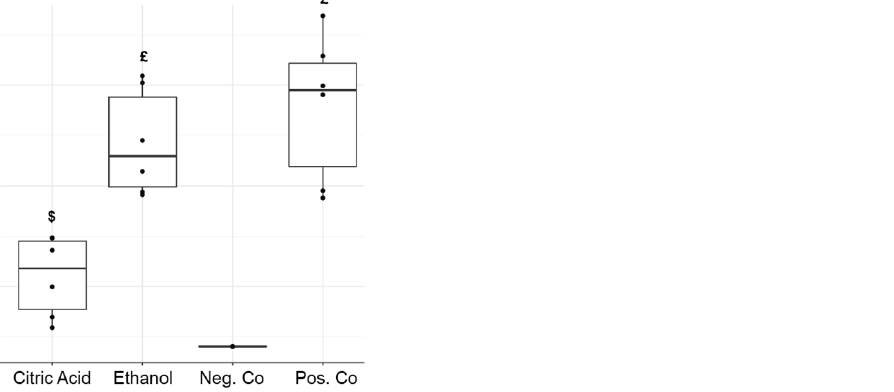
Figure 3. Fluorescence intensity of InViS after incubation with citric acid (1 M) and 70% ethanol. InViS in PBS and InViS treated with OEG served as negative and positive control, respectively. Results represent the mean and corresponding standard deviations from three independent experiments with two replicates each. $ p < 0.01, £ p < 0.001 compared to negative